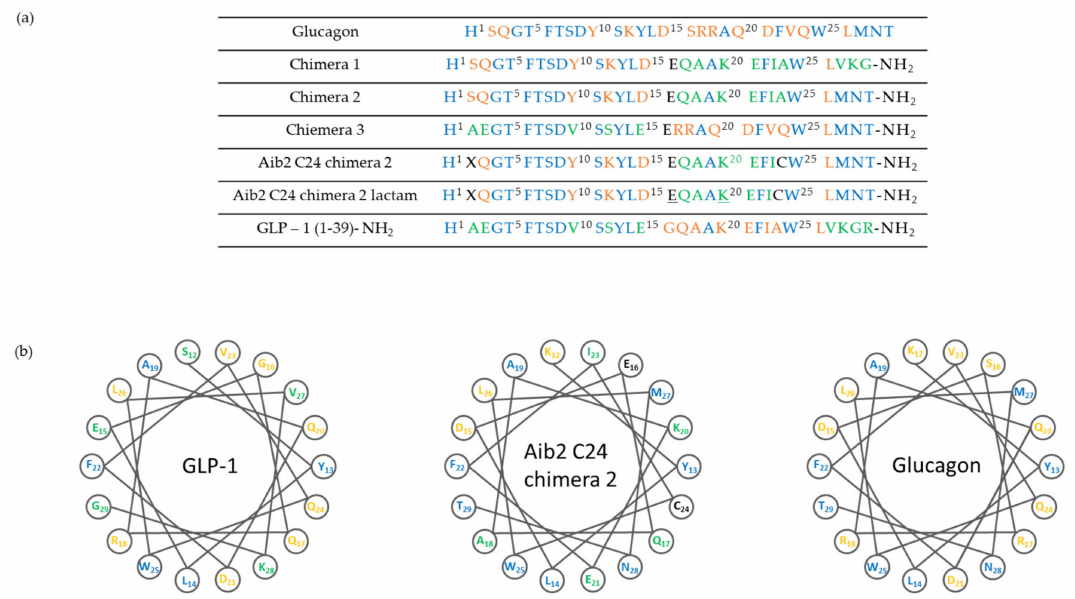
Figure 5. Structure of glucagon, GLP-1 and chimeric peptides. ( a ) Amino acid sequence and structure of glucagon and GLP-1 chimera. Underlined residues indicate site of lactam formation. ( b ) Helical wheel representation of glucagon, GLP-1 and chimeric peptide showing residues